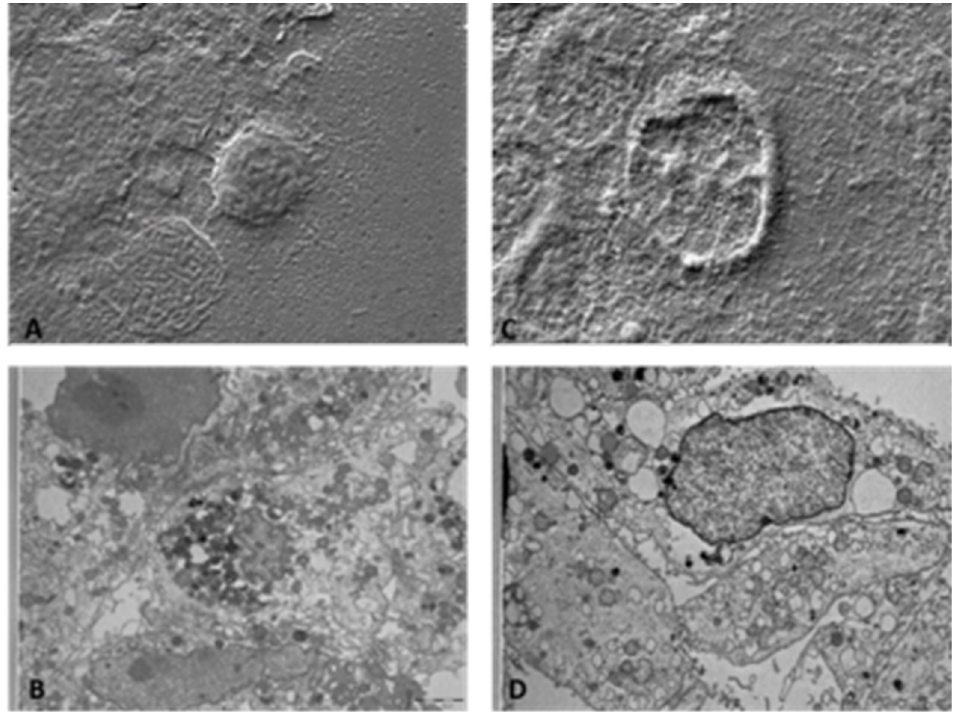
Figure 4. Effects of 10,000 ppm HOCl nebulization on HaCaT cell morphology analyzed by SEM and TEM microscopies. ( A ) SEM imageT0h 10,000 ppm: at maximum conc. of the SEM treatment the cells appear disrupted and with loss of adhesion. ( B ) TEM image T0h 10,000 ppm: confirms the presence of a high percentage of necrotic, pycnotic nuclei and cytoplasmic disaggregation. ( C ) SEM image T24h 10,000 ppm: at this conc. at SEM the cells appear deeply damaged with loss of both cytoplasm and nuclear support. ( D ) TEM image T24h 10,000 ppm: confirms the presence of a widespread percentage of cells in necrosis, pycnotic nuclei and disaggregation of cytoplasm, and there are numerous cells in apoptosis. 5K magnification (for both SEM and TEM pictures).